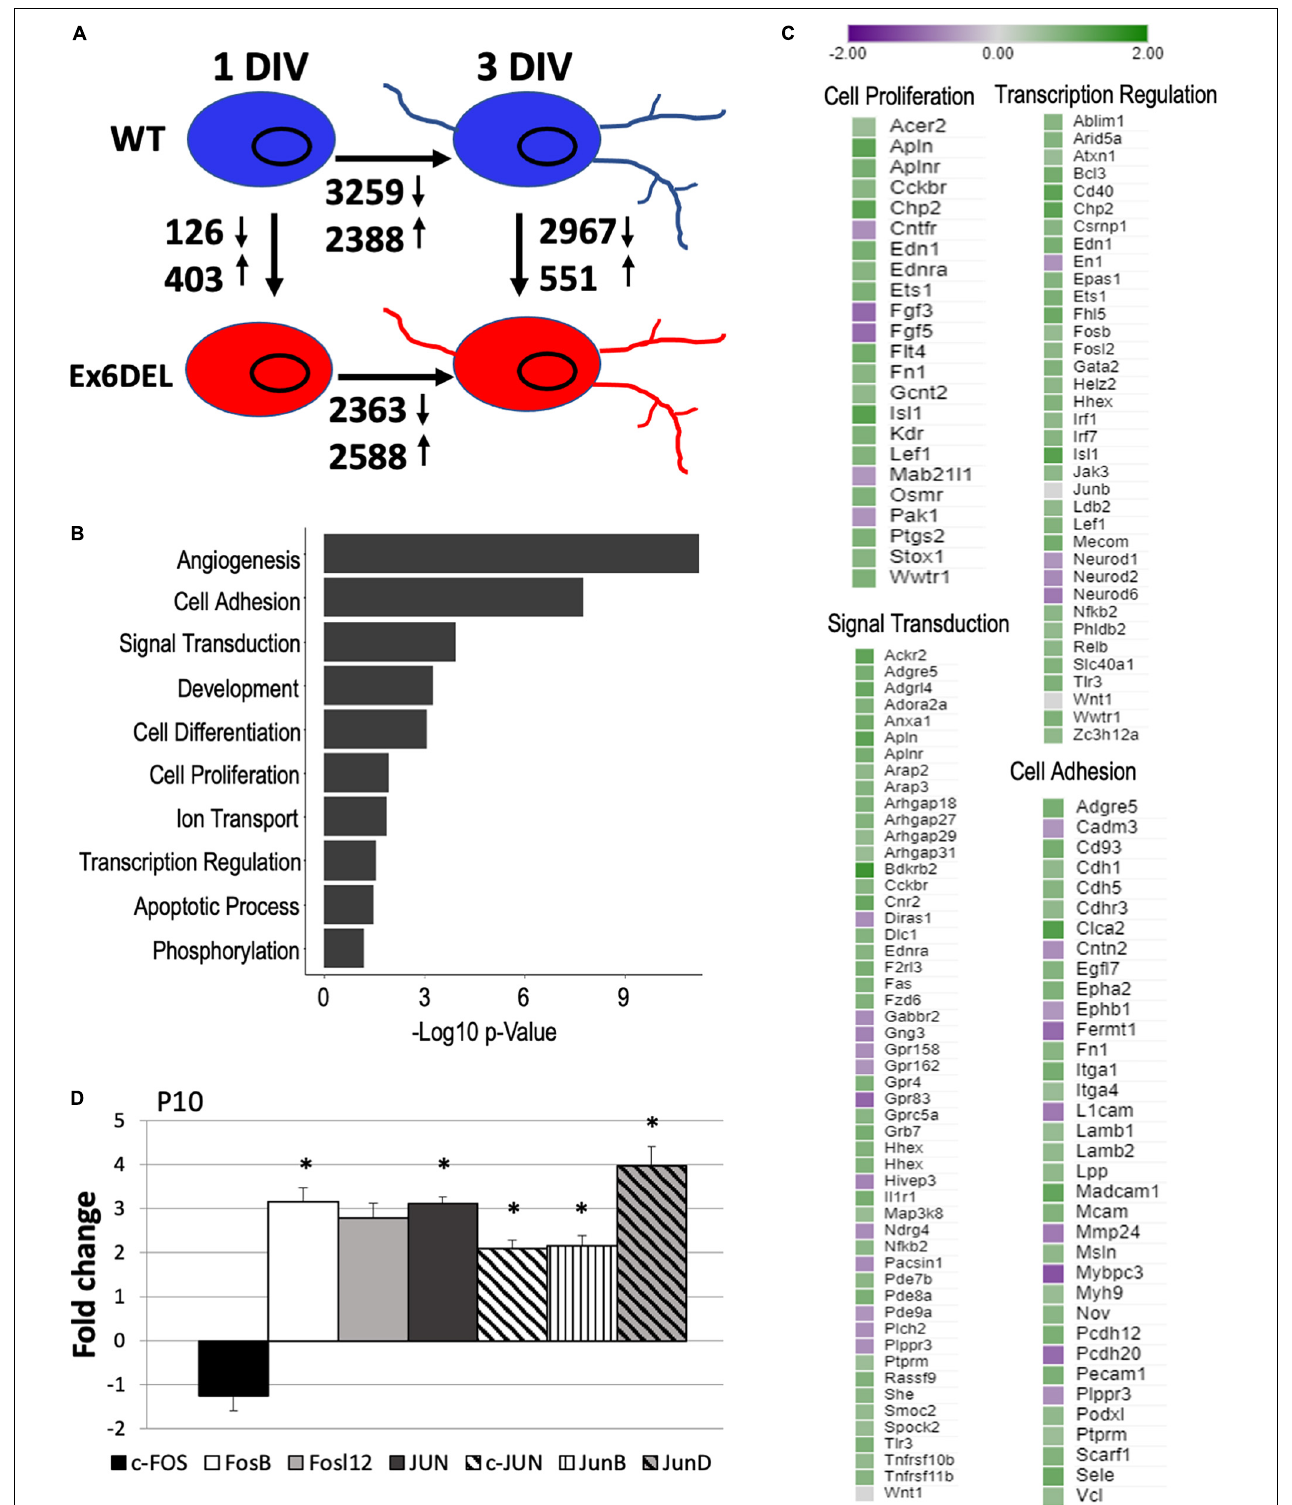
FIGURE 3 | RNAseq analysis of WT and Ex6DEL cultures. (A) Schematic diagram showing the numbers of differentially expressed genes (DEGs) between different samples (WT and Ex6DEL) and days in culture. (B) GO term analysis of the DEGs observed at 1 DIV. (C) DEG lists for some of the top GO terms. (D) RT-qPCR validation of Fos/Jun genes from RNA isolated from P10 cerebella. ∗ p < 0.05.